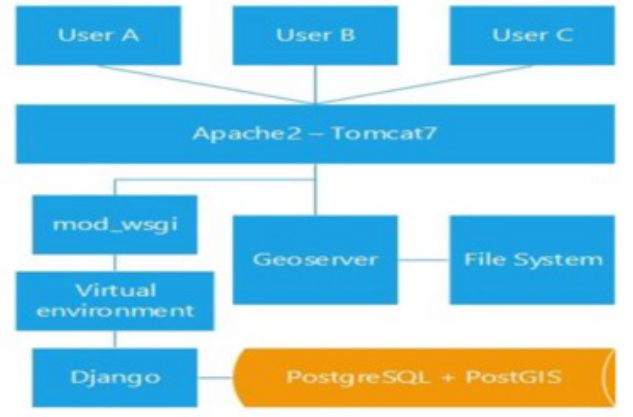
Figure 3. Application structure.